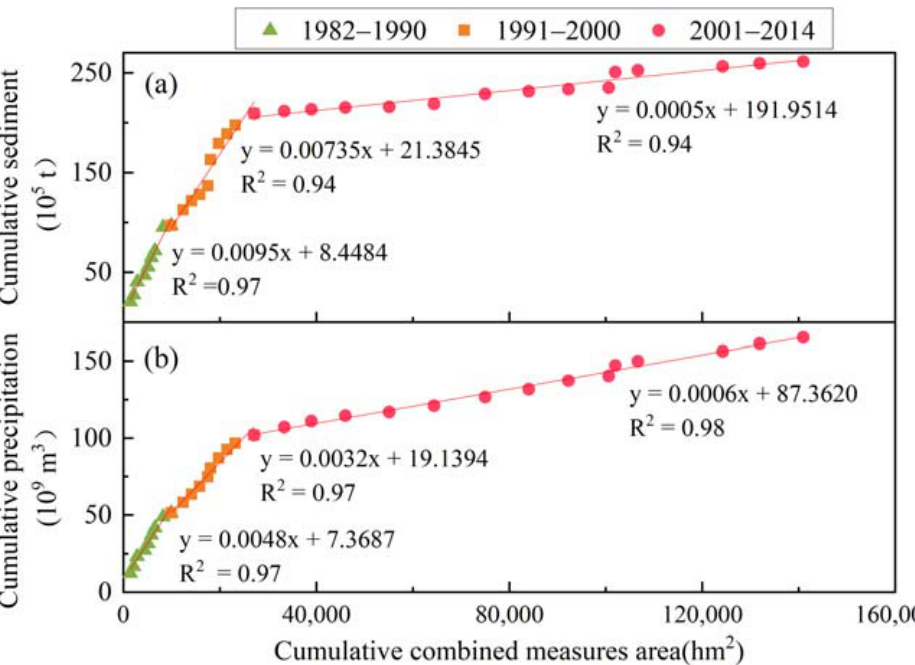
Figure 9. Relationship between soil and water control area and streamflow ( a ) and sediment yields ( b ) in